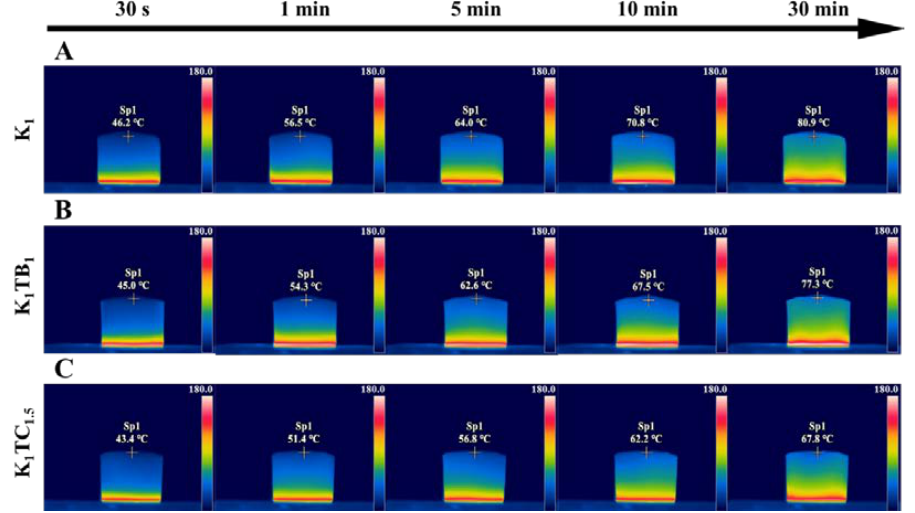
Figure 7. Thermal infrared images of K 1 ( A ), K 1 TB 1 ( B ), and K 1 TC 1.5 ( C ) in 30 min.